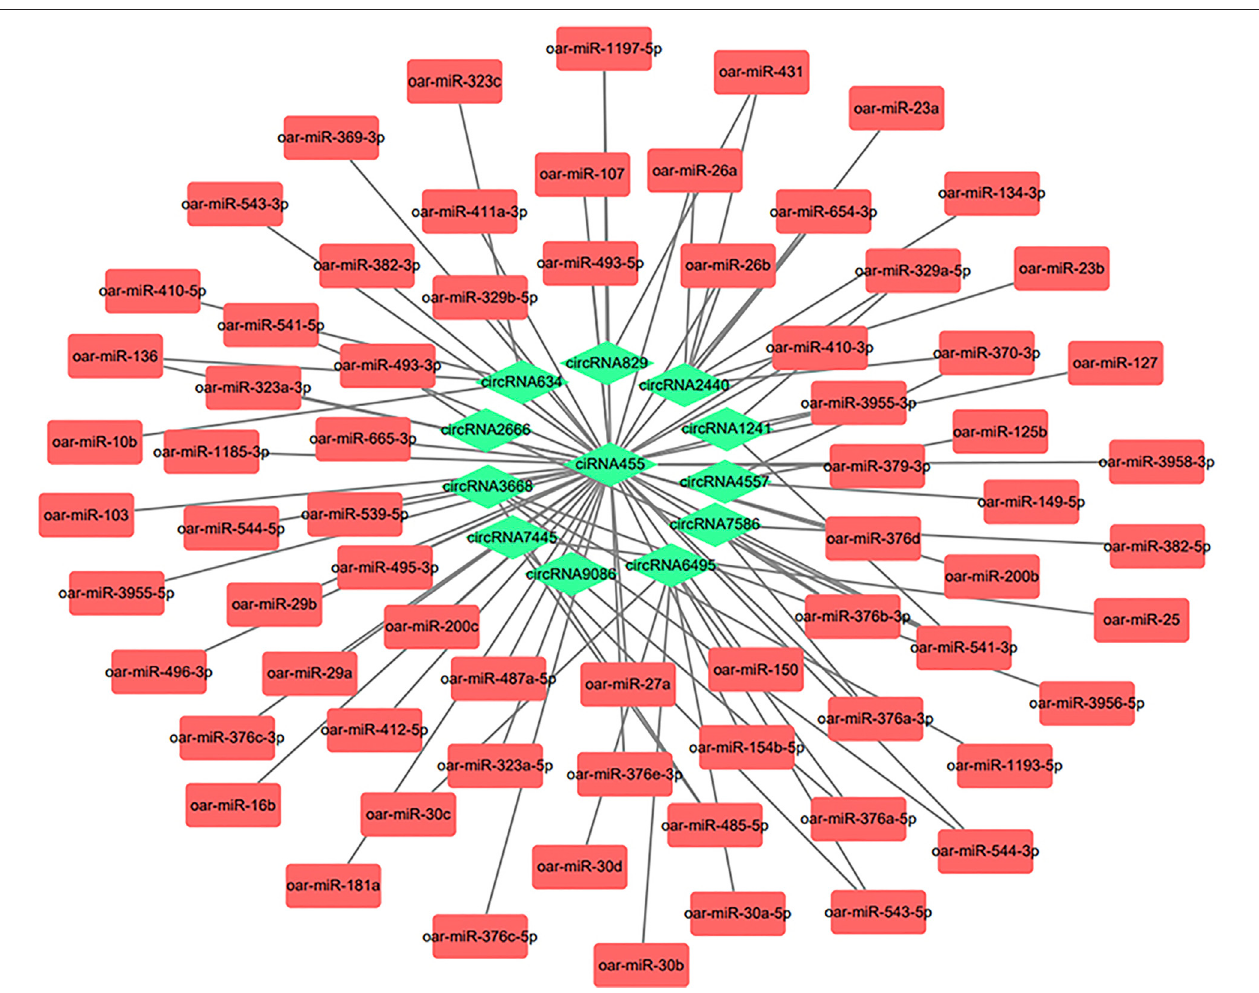
FIGURE 6 | Interaction analysis network diagram of circular RNAs (circRNAs) and micro RNAs (miRNAs). The circRNA-miRNA network diagram was constructed based on 12 circRNAs and 70 miRNAs.